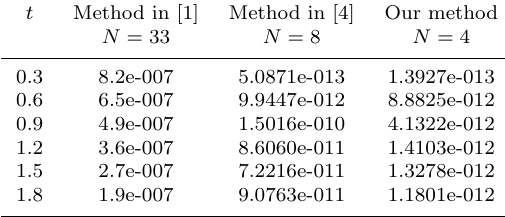
Table 4. Absolute errors of Example 3 using methods in [1,4] and LG-SM for x = 0 .